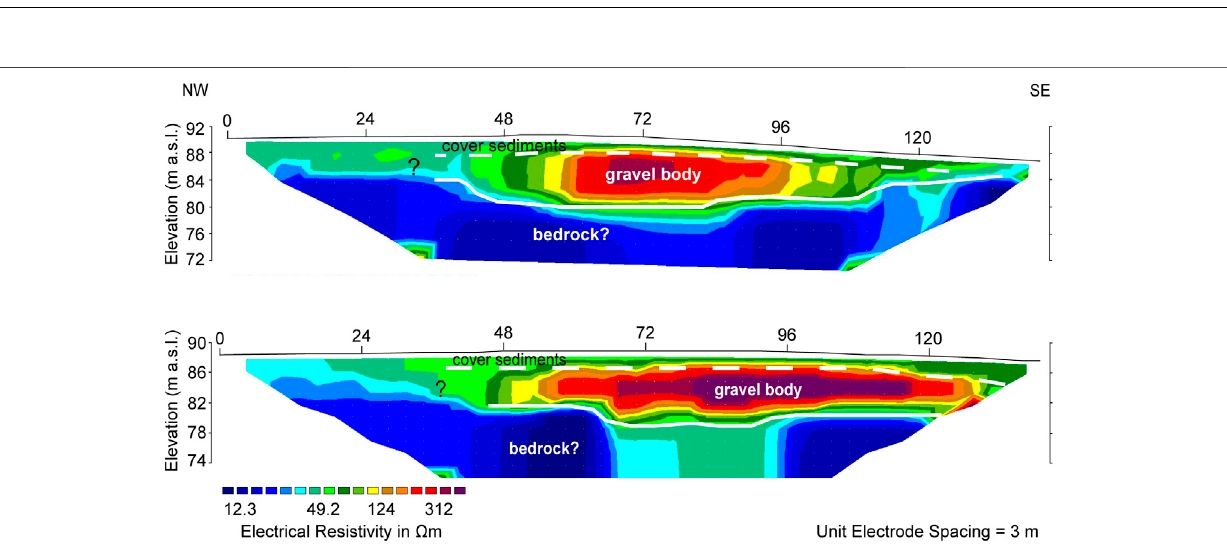
FIGURE 4 | Inversion models of ERT-transects CRV ERT 3 (upper) and CRV ERT 4 (lower) . The coarse-grained sediments that were found at the bottom of the excavation trenches are depicted by a unit of high resistivity values while overlying cover sediments show signi fi cantly lower resistivity values. The shape of these units indicates the presence of a fi ll terrace with overlying cover sediments. The base suggests incision into underlying strata at identical elevation AMSL. Stratigraphic information for the underlying units that are characterized by low resistivity values rising toward the northwest is not available. The location of the transects is depicted in Figure 1C